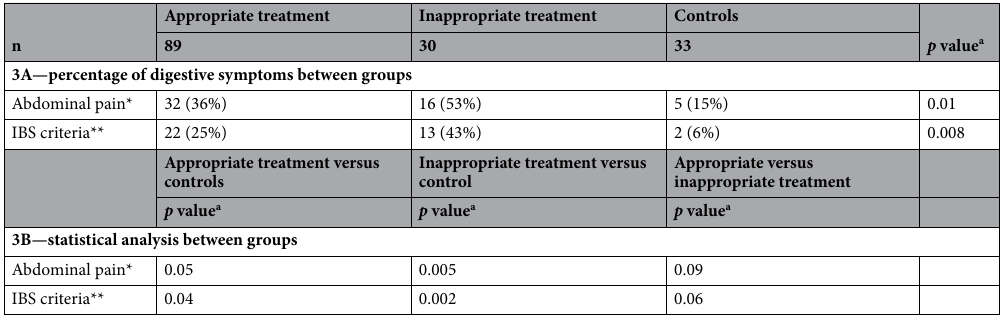
Table 3. Abdominal pain, irritable bowel disease syndrome and hydrocortisone dose. *Number of subjects with abdominal pain at least once a week during the last 3 months. **Number of patients fulfilling ROME IV criteria for irritable bowel disease. A p value < 0.05 was considered to be significant. a Chi 2 test with Holm